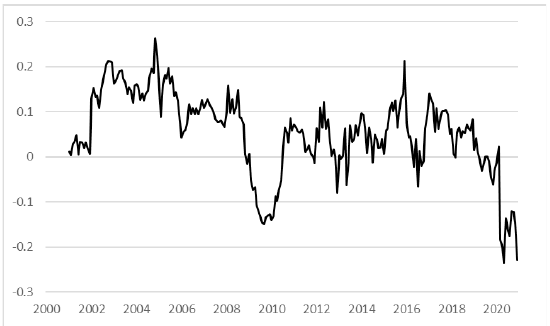
Figure A5. ACF for the turnover for wholesale and retail trade and repair of motor vehicles and motorcycles in Bulgaria (logs, first differences)